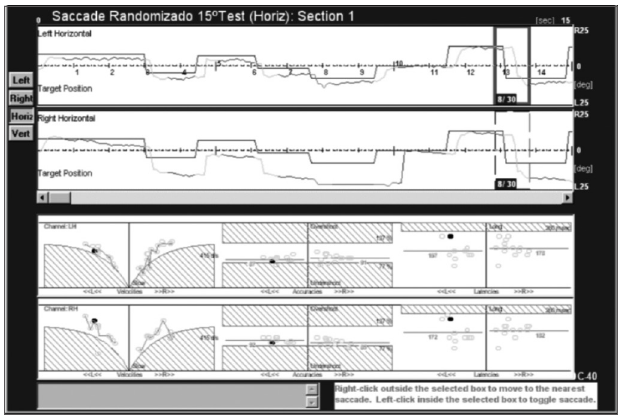
Figura 2. Sacádicos de paciente com patologia cerebelar. Vide hipo- metria e sacádico de correção.